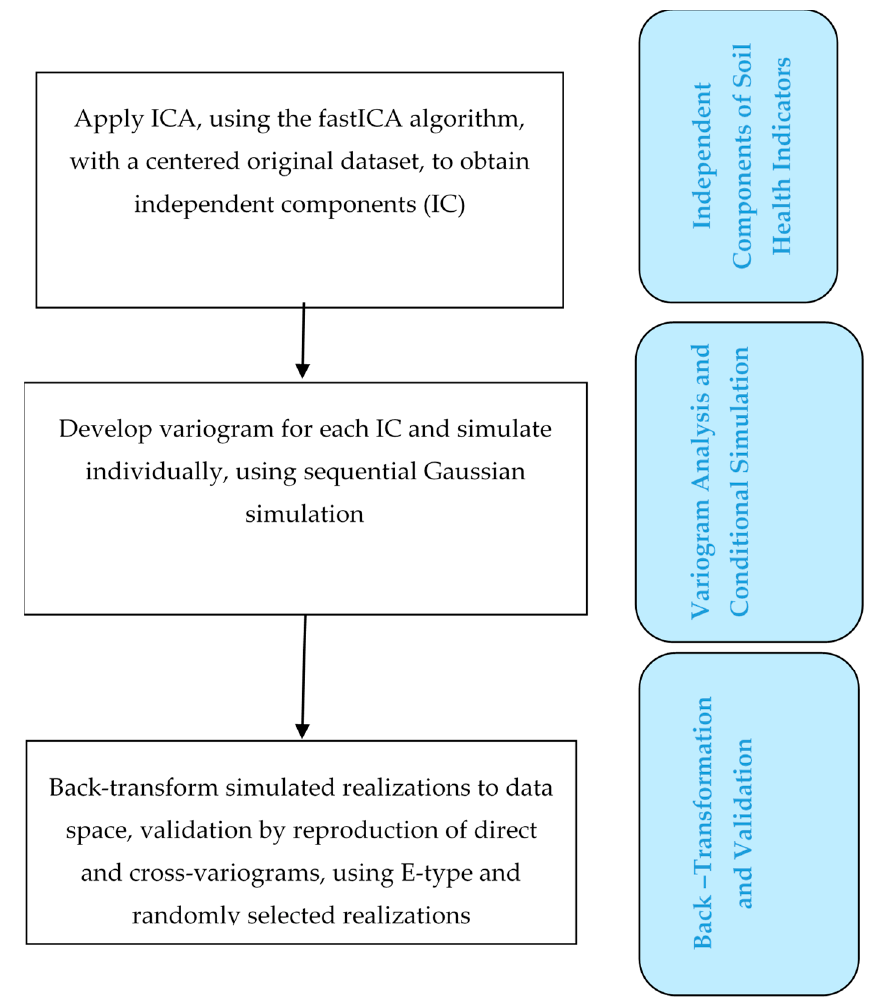
Figure 4. Workflow of independent component analysis (ICA) and sequential Gaussian simulation.